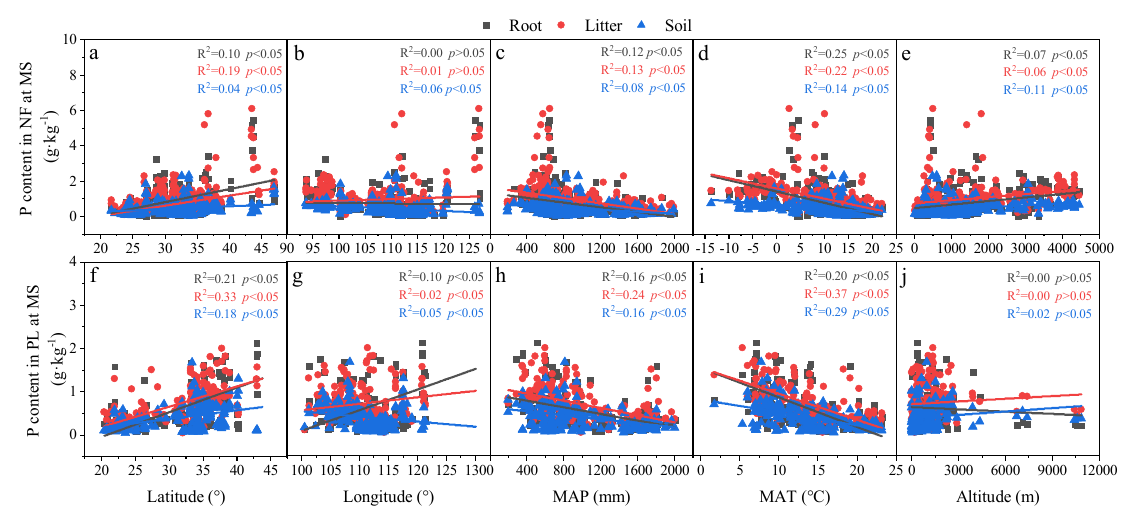
Figure 6. P concentration changes with latitude ( a , f ), longitude ( b , g ), mean annual precipitation (MAP) ( c , h ), mean annual temperature (MAT) ( d , i ) and altitude ( e , j ) in different forest origins in the middle stage (MS). The numbers of forest sites are 344 and 199 for NF − MS and PL − MS,